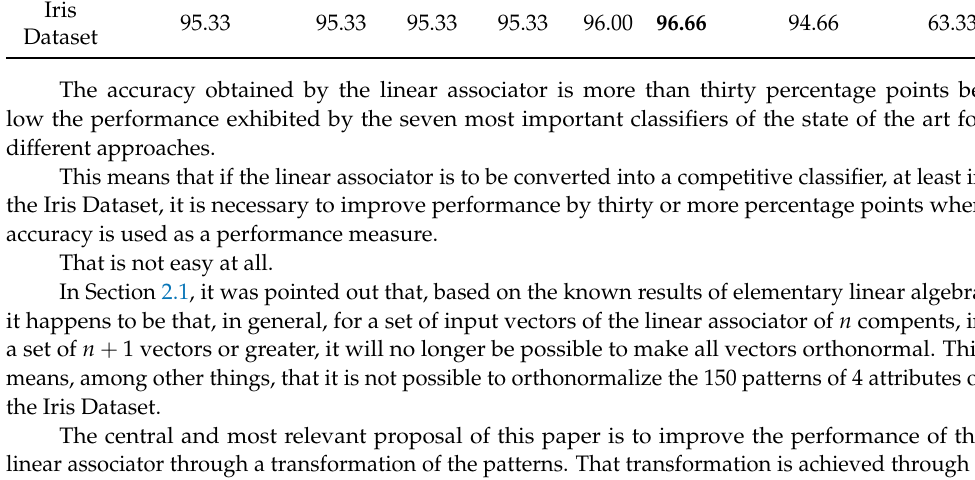
Table 1. Accuracy values (as percentages) exhibited by the state-of-the-art classifiers in the Iris Dataset. Naïve Bayes 1-NN 3-NN C4.5 SVM MLP Random Forest LA Iris 95.33 95.33 95.33 95.33 96.00 96.66 94.66 Dataset